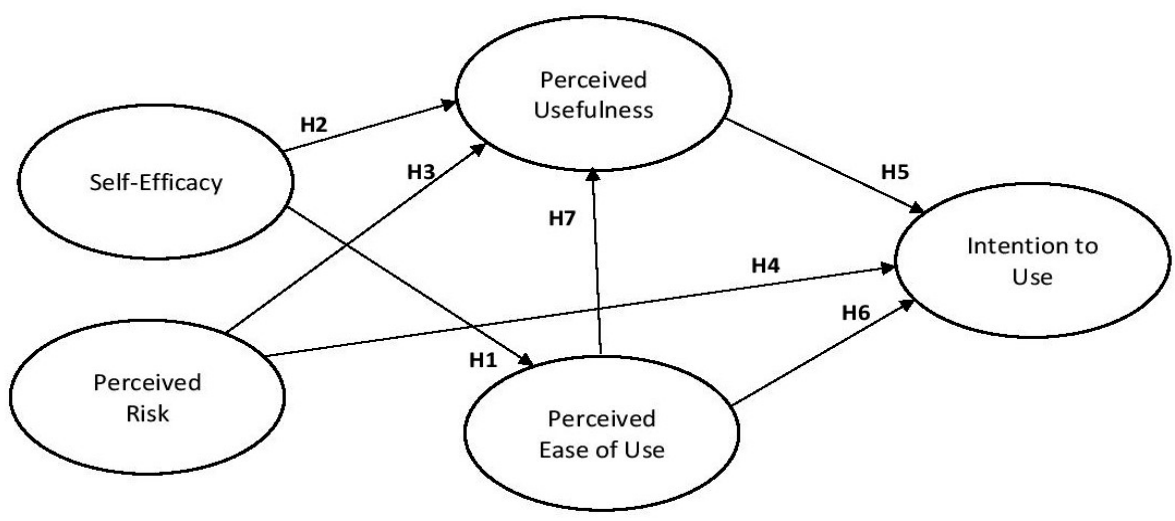
Figure 1. Conceptual framework and hypotheses.